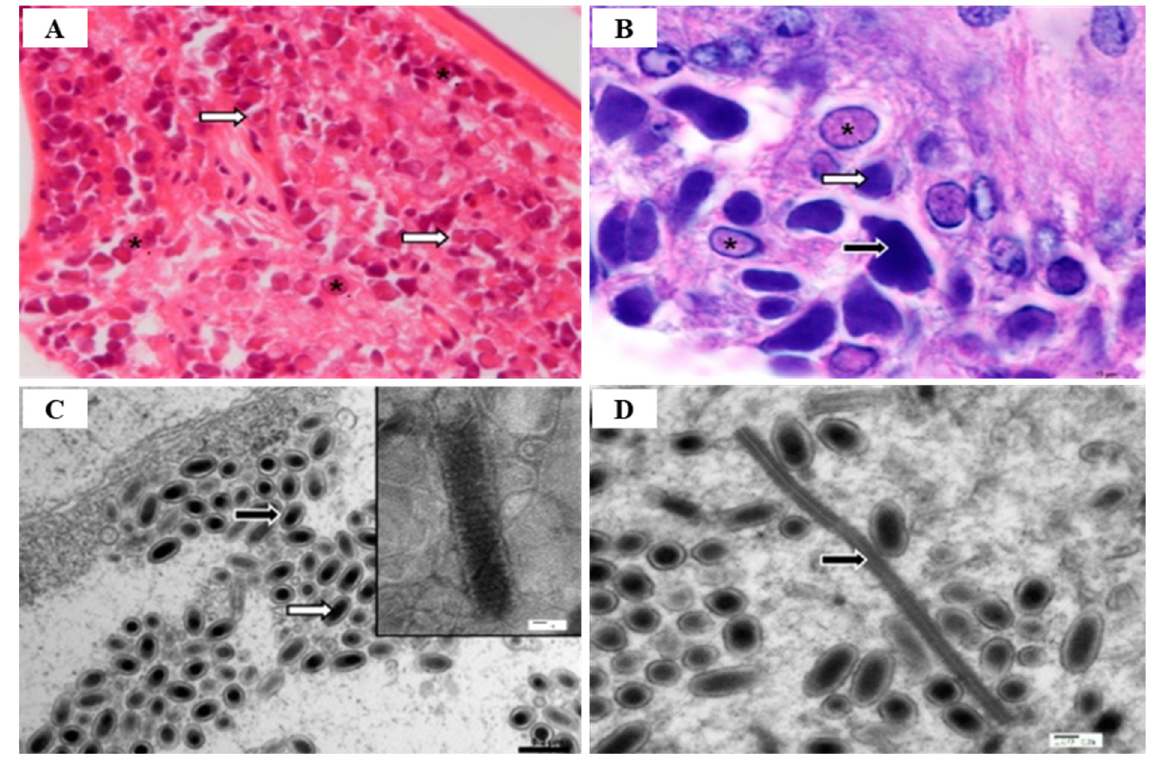
Figure 7. Penaeus vannamei infected with white spot syndrome virus (WSSV). The infection progresses through different stages that can be seen in the nucleus via histology. ( A ) Early-stage infected cells display enlarged nuclei with marginalized chromatin and a homogenous eosinophilic central region. These then develop an intranuclear eosinophilic Cowdry A-type inclusion (*); this can be surrounded by a clear halo beneath the nuclear membrane (white arrow). Scale bar = 25 µ m; ( B ) The eosinophilic inclusion usually expands to fill the nucleus (*). This inclusion becomes basophilic when staining and denser in color as the infection progresses (white arrow). Nuclei then disintegrate so that the content fuses with the cytoplasm (black arrow). Scale bar = 10 µ m. H & E stain; ( C ) WSSV virions appear ovoid in shape and contain an electron-dense nucleocapsid (white arrow) within a trilaminar envelope (black arrow). Scale bar = 0.2 µ m. Inset. Negatively stained WSSV nucleocapsid, showing the presence of cross-hatched or striated material that is structured as a series of stacked rings of subunits and is a key diagnostic feature of WSSV. Scale bar = 20 nm; ( D ) Presumptive nucleocapsid material within the nucleus prior to envelopment. This material is cross-hatched or striated in appearance and linear prior to its incorporation in the formation of mature WSSV particles. This linear nucleocapsid material is observed sporadically in the manufacture of the WSSV particles. Scale bar = 100 nm. Transmission electron microscopy images (Source: Verbruggen et al., 2016, https://doi.org/10.3390/v8010023 accessed on 11 May